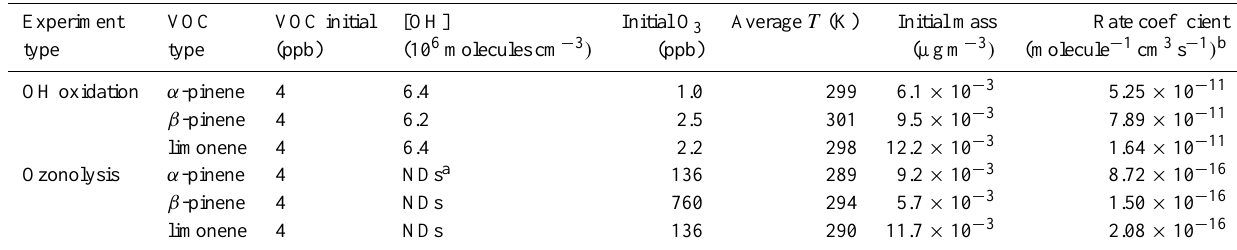
When an infinitesimal concentration of i , d C g